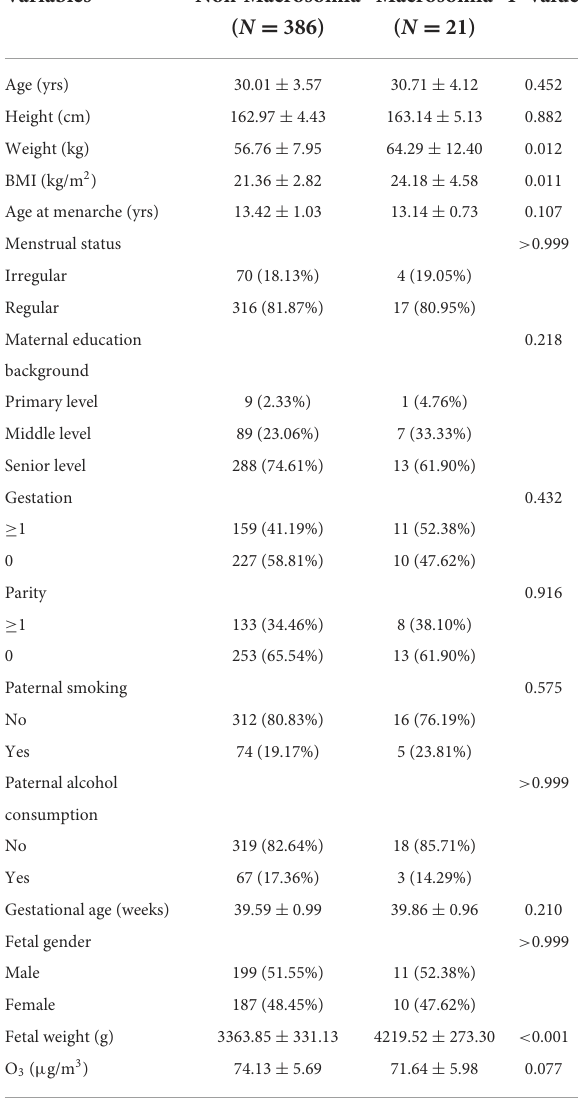
TABLE 1 Comparison of baseline characteristics between groups ( N =